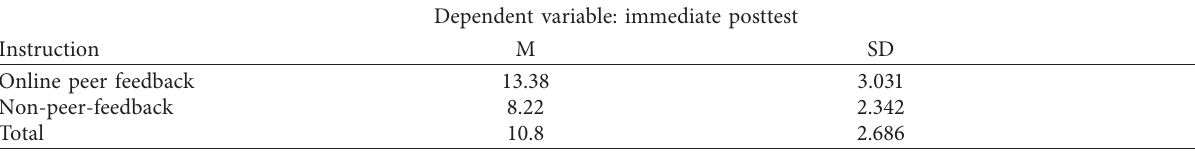
Table 2: Descriptive statistic for comparing the online peer feedback and non-peer-feedback.